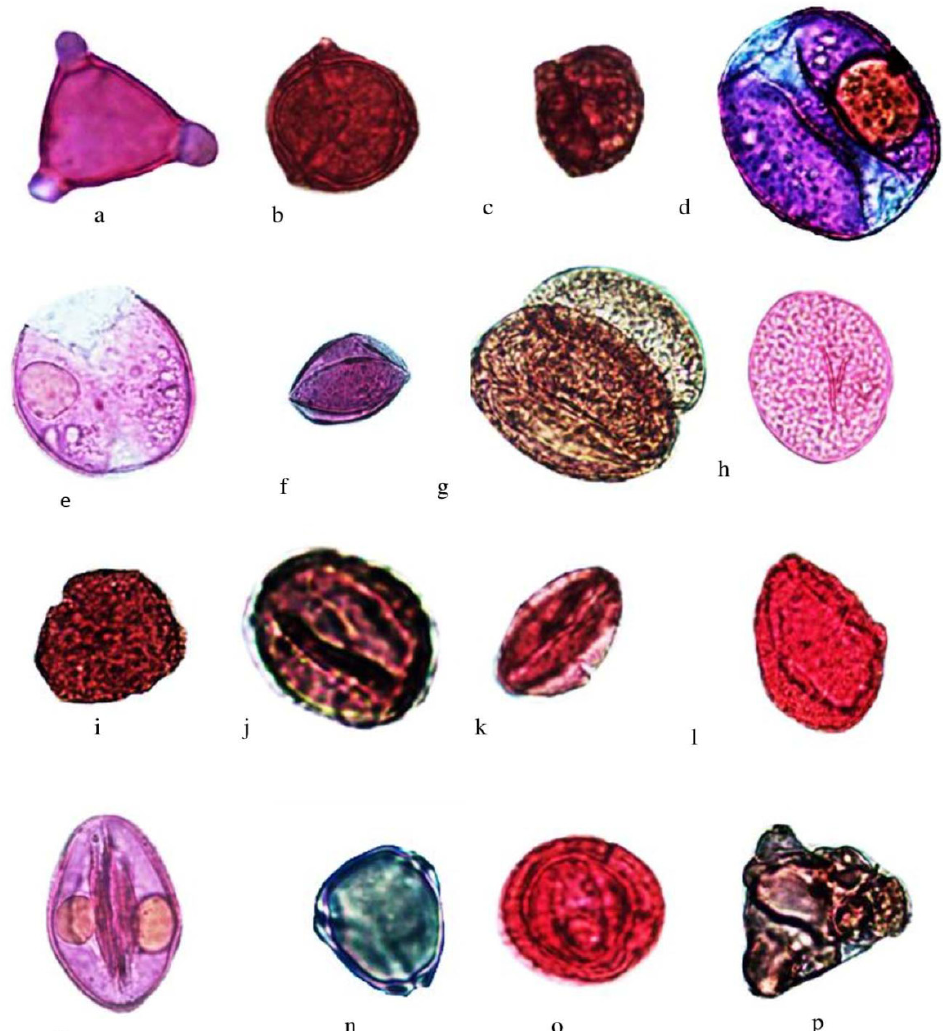
Figure 4. Optical microscopy images of pollen. ( a ) Gevuina Avellana. ( b , c ) Sanguisorba minor. ( d – g ) Pinus sp. ( h ) Sparganium sp. ( i – l ) Quercus sp. ( m ) Juniper sp. ( n ) Myrtaceae. ( o ) Artemisia sp. ( p ) Interporopollenites